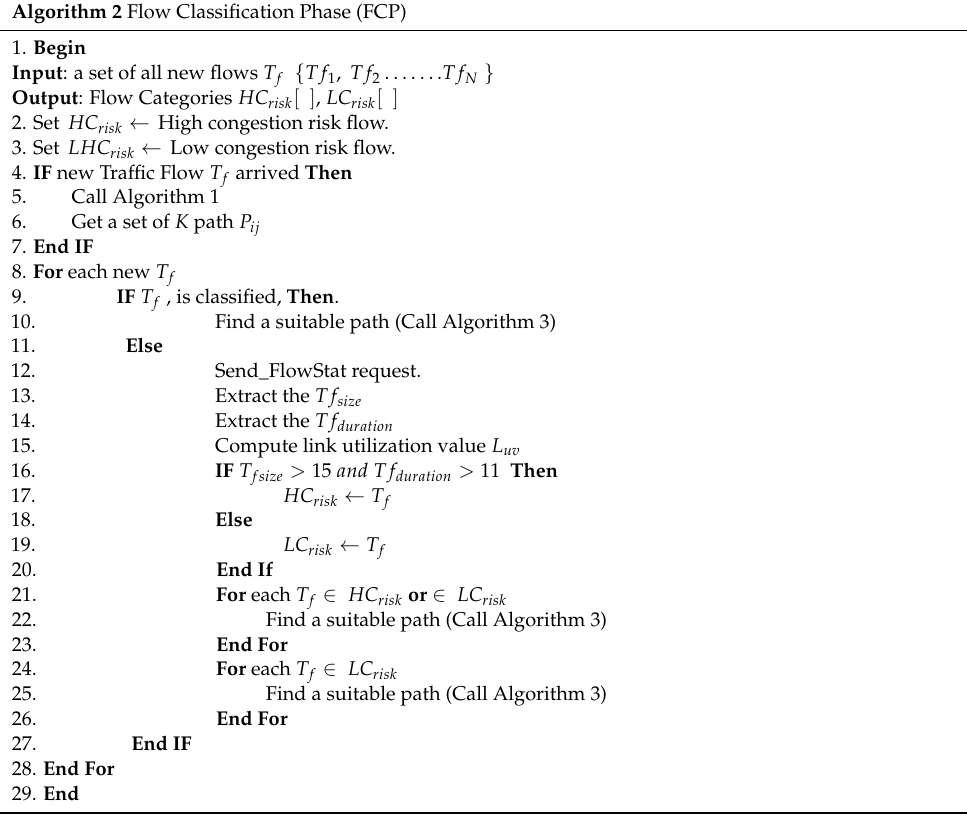
Algorithm 2 Flow Classification Phase